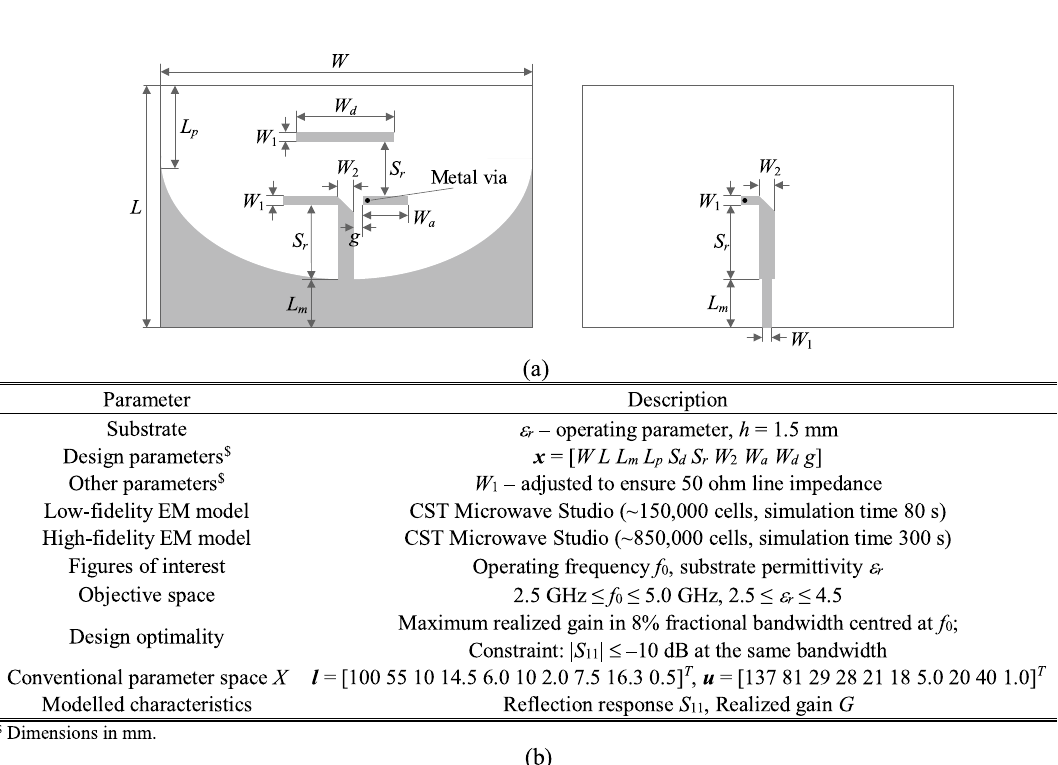
Figure 9. Antenna II: dual-band uniplanar dipole antenna: ( a ) antenna geometry, ( b ) antenna parameters.